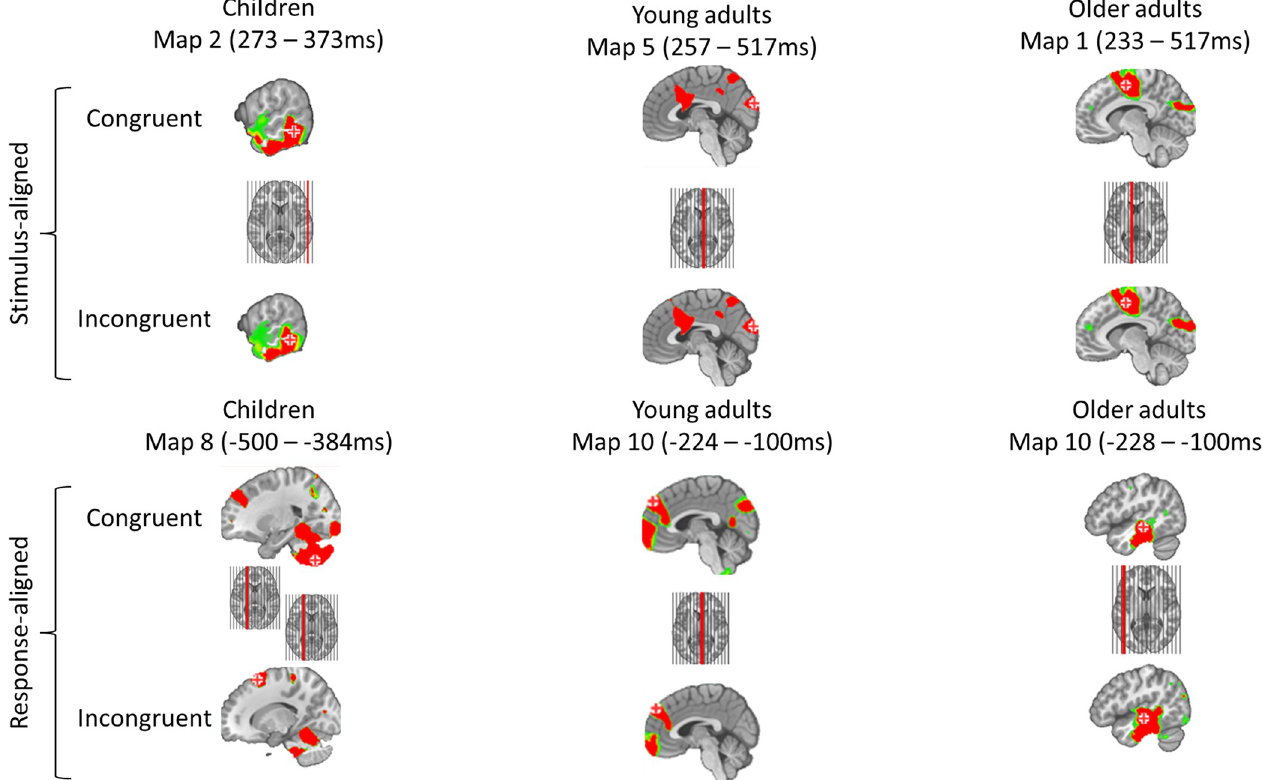
Fig 5. Sources relative to the timing of the microstates disentangling groups or conditions in regards of the Stroop effect. Red cross indicates the maximum of activation.